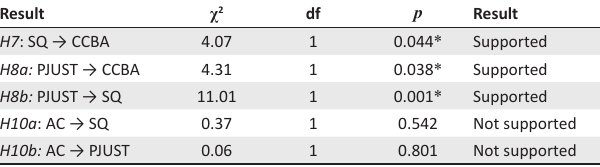
TABLE 6: Moderation results of direct